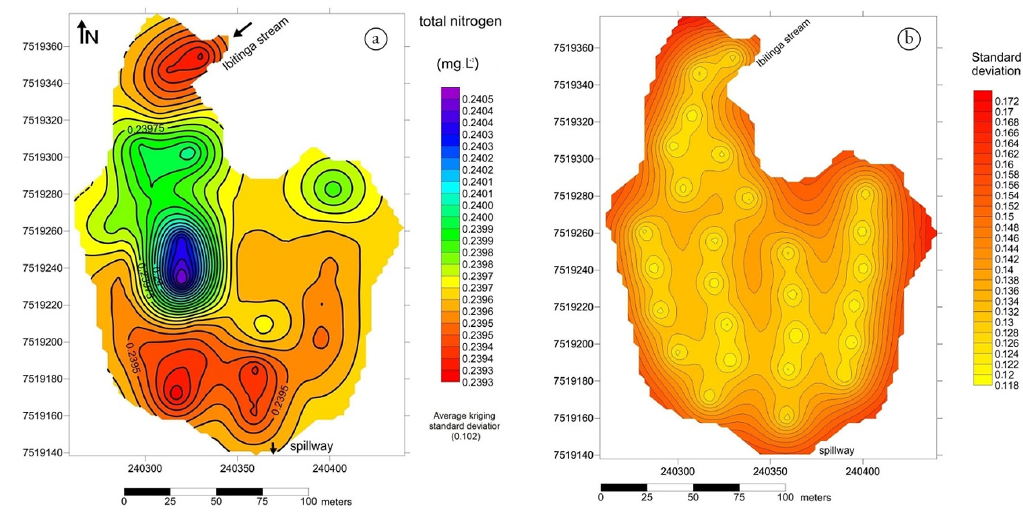
Figure 6. Estimates (a) and standard deviations (b) of total nitrogen concentrations.